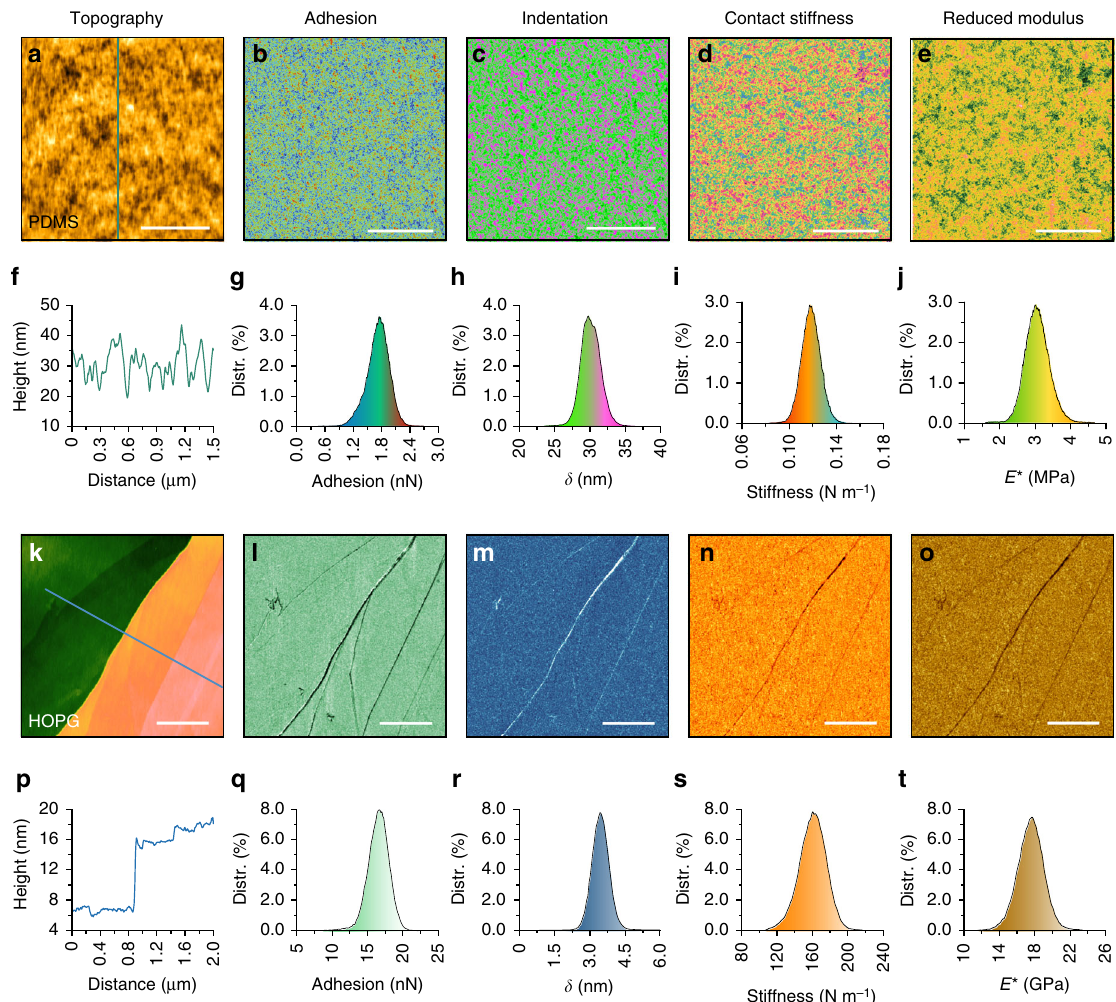
Fig. 3 Nanomechanical maps of the PDMS and HOPG surfaces using Probe I in air. a – e PDMS topography image and the maps of adhesion, indentation, contact stiffness and reduced elastic modulus. f Cross-section along the line shown in a . g – j Corresponding histograms obtained from b to e . k – o HOPG topography image and maps of adhesion, indentation, contact stiffness and elastic modulus. p Cross-section along the line shown in k . q – t Corresponding histograms obtained from l to o . Scale bar, 500